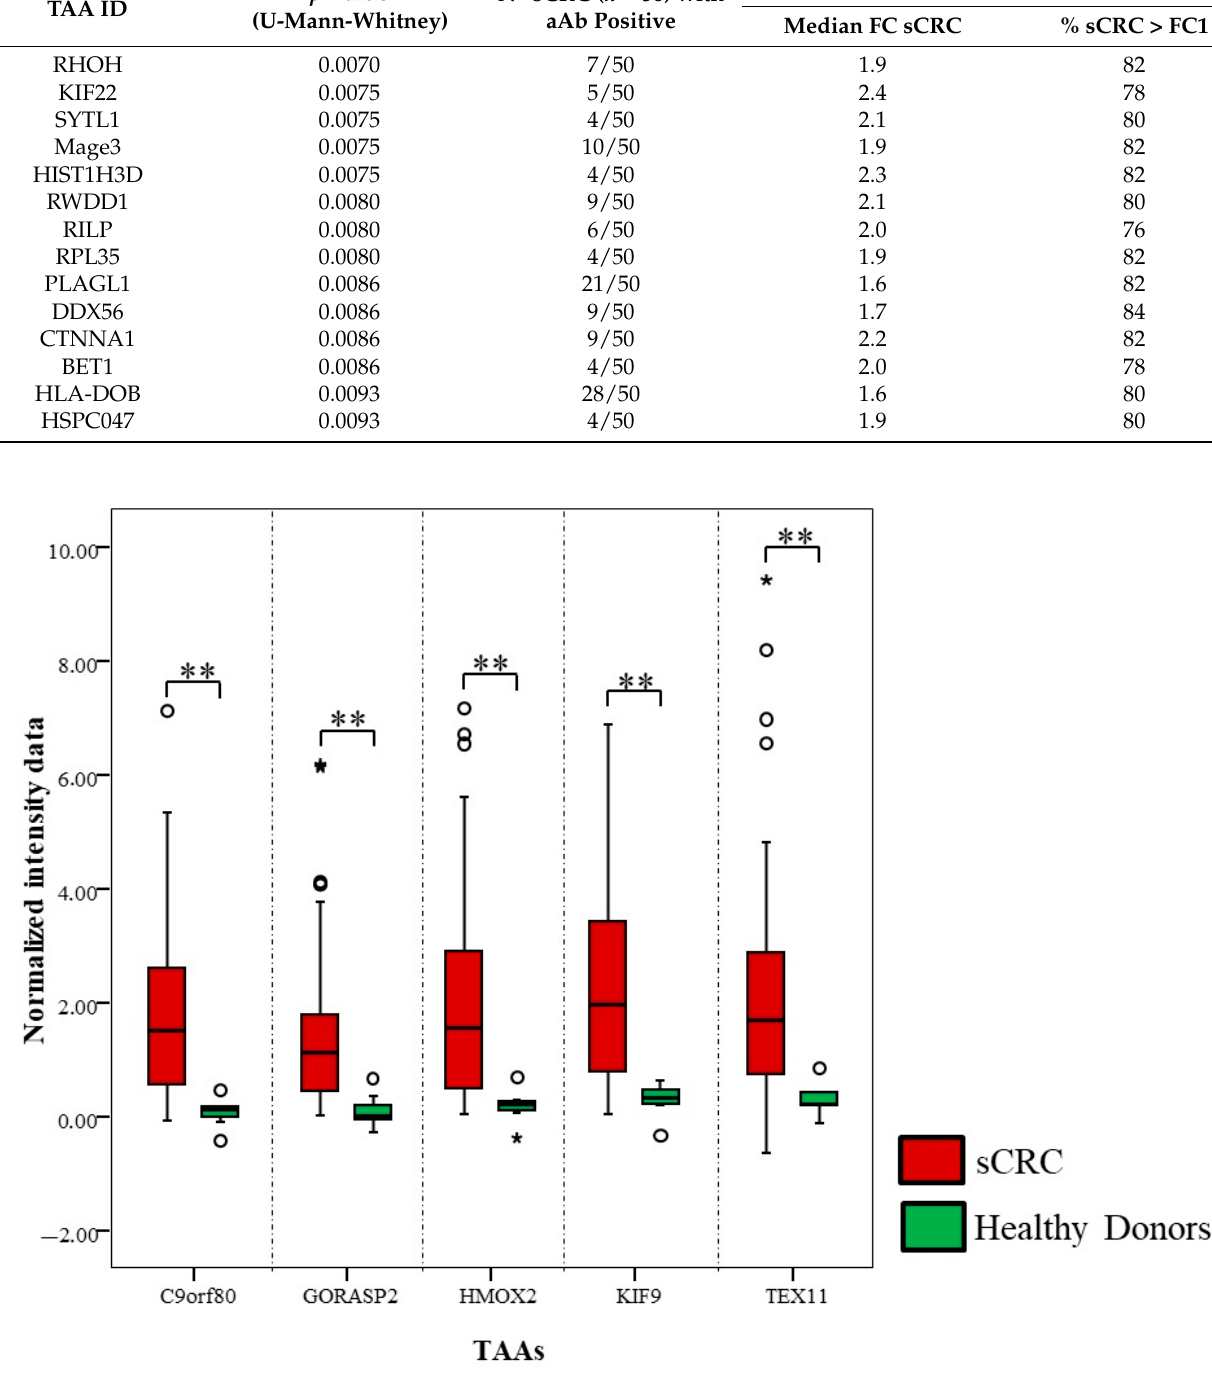
Figure 4. Normalized intensity data of aAbs against TAAs with statistical significance ( p < 0.001) from healthy controls ( n = 7) and sCRC patients ( n = 50) are represented by double asterisk (**). Notched-boxes extend from the 25th to 75th percentile values; the lines in the middle and vertical lines correspond to the median values and the 10th and 90th percentiles, respectively. Outlier cases, identified as cases between 1.5–3 and/or >3 fold the interquartile range, are represented by circles and star, respectively.